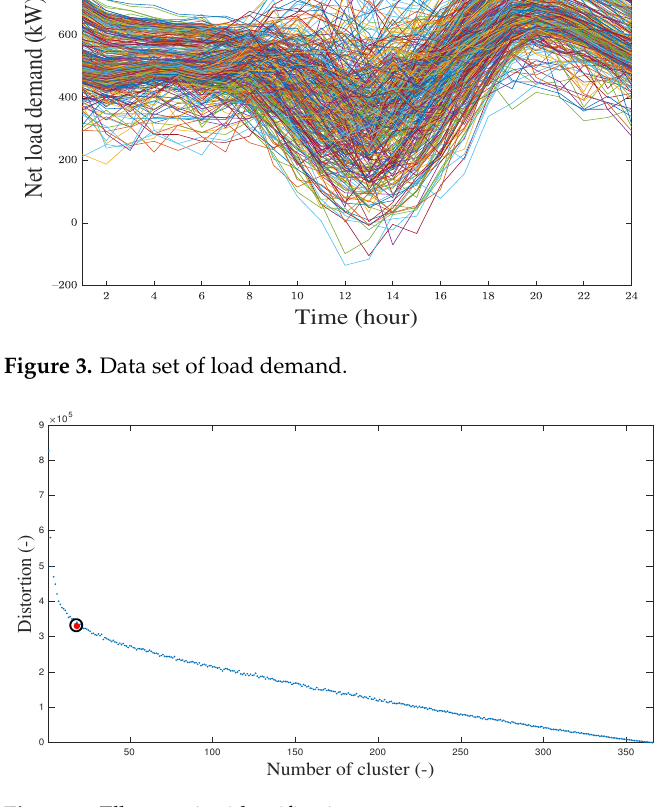
Figure 4. Elbow point identification.